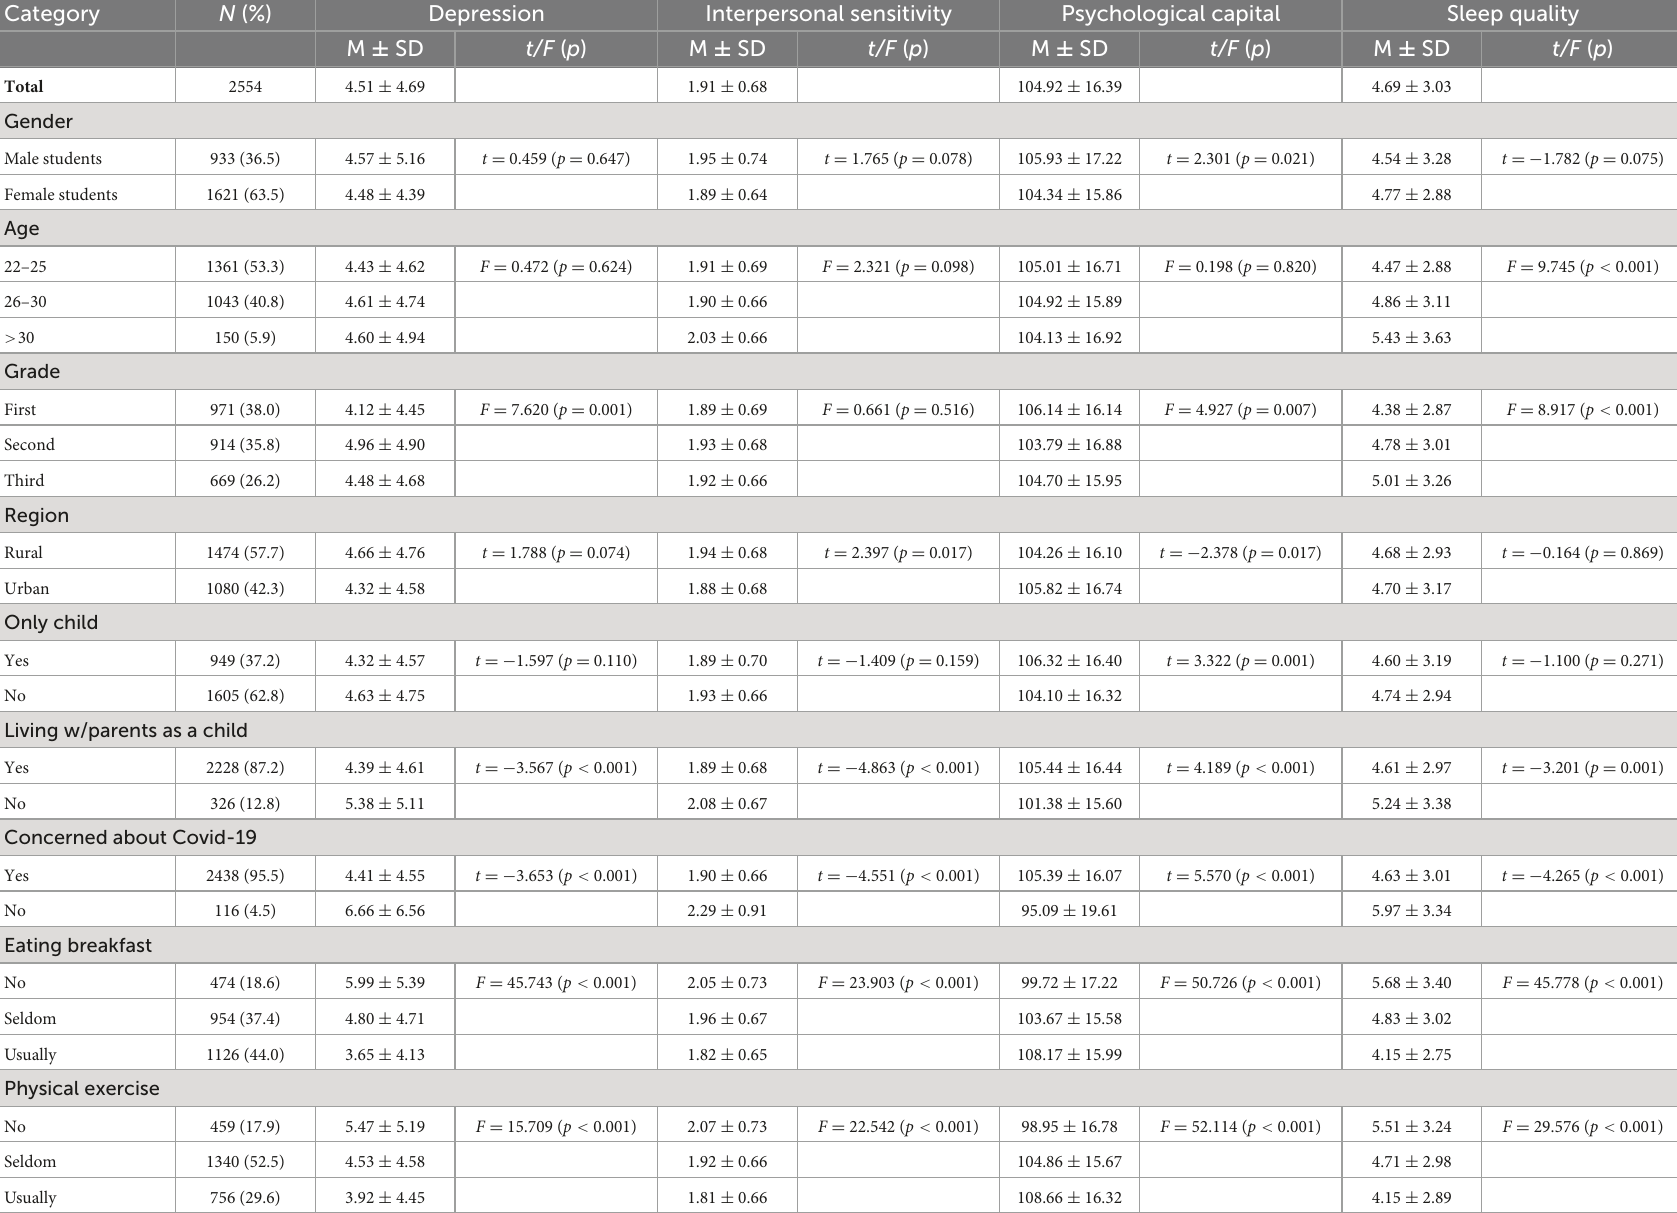
TABLE 1 Sociodemographic characteristics of four variables among postgraduate students.